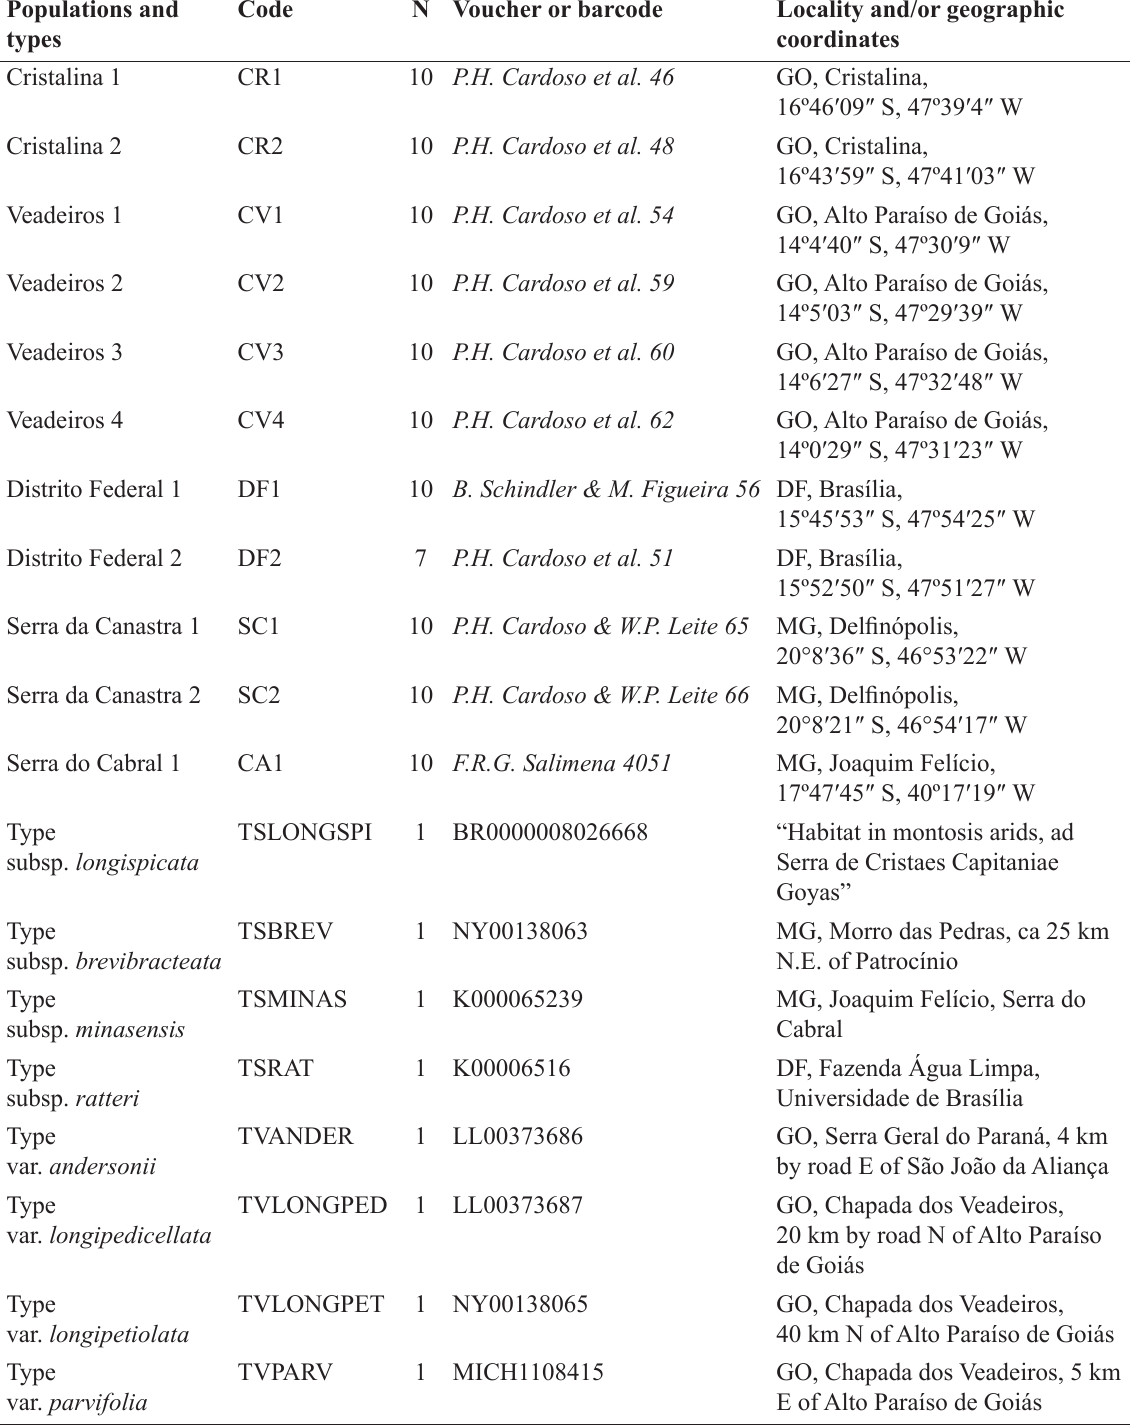
Table 2. Natural populations and nomenclatural types of the Stachytarpheta longispicata complex used in this study, including codes, number of specimens – sample size (N), vouchers or barcodes, and locality information. Vouchers were made from one specimen per population and are deposited at CESJ herbarium. Abbreviations: DF = Distrito Federal; GO = Goiás; MG = Minas